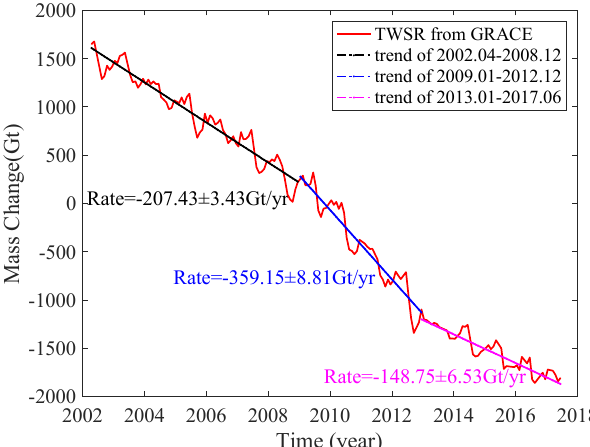
Figure 3. GrIS mass changes from the Gravity Recovery and Climate Experiment (GRACE) between April 2002 and June 2017 by applying a forward modeling technique to suppress the ocean-land leakage effect.